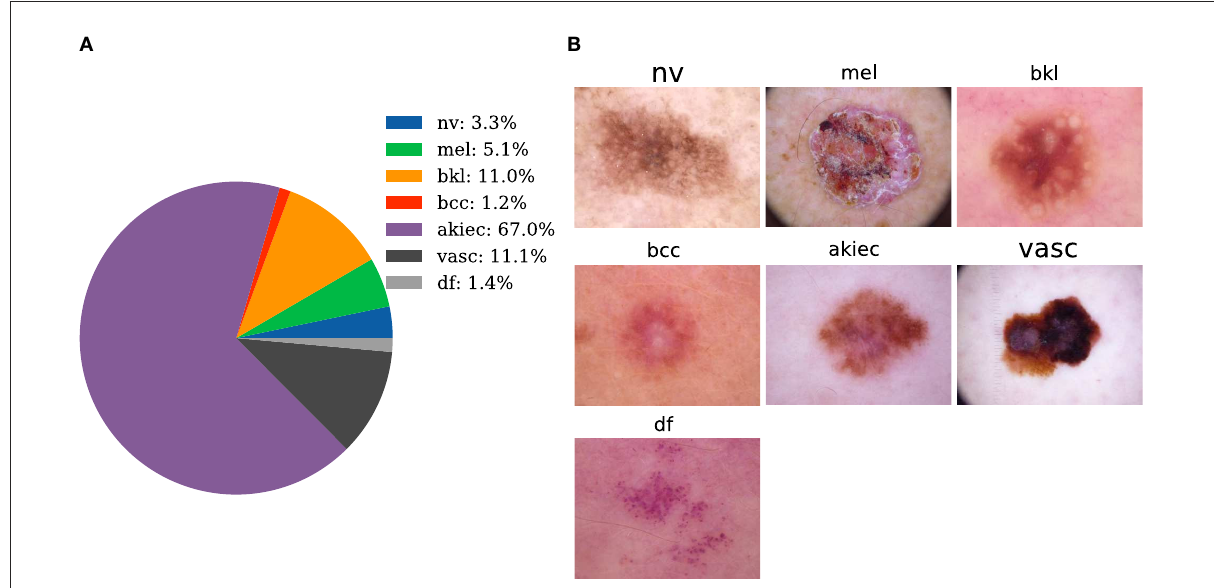
FIGURE2 Data preparation. (A) The distribution of pigmented skin diseases in the specimens. (B) Photos of the representative pigmented skin diseases in each sampling category for clinical